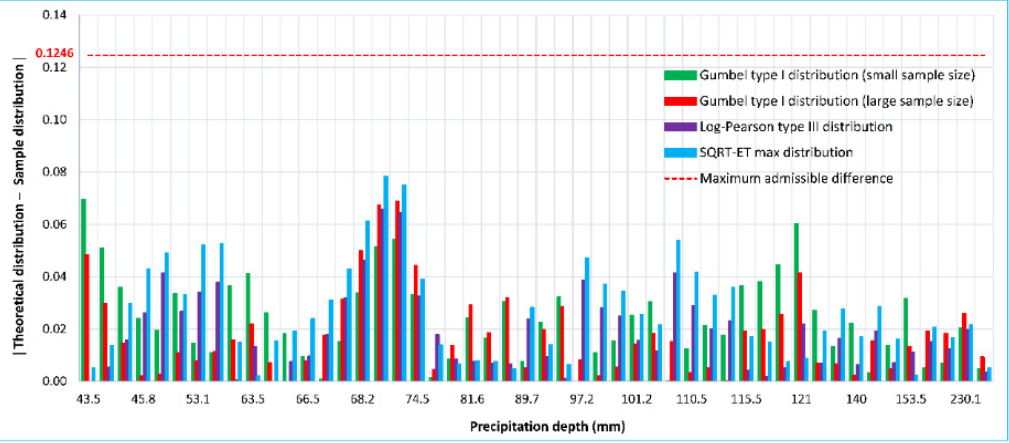
Figure 7. Differences between theoretical and sample distributions (absolute value) against precipitation depth.